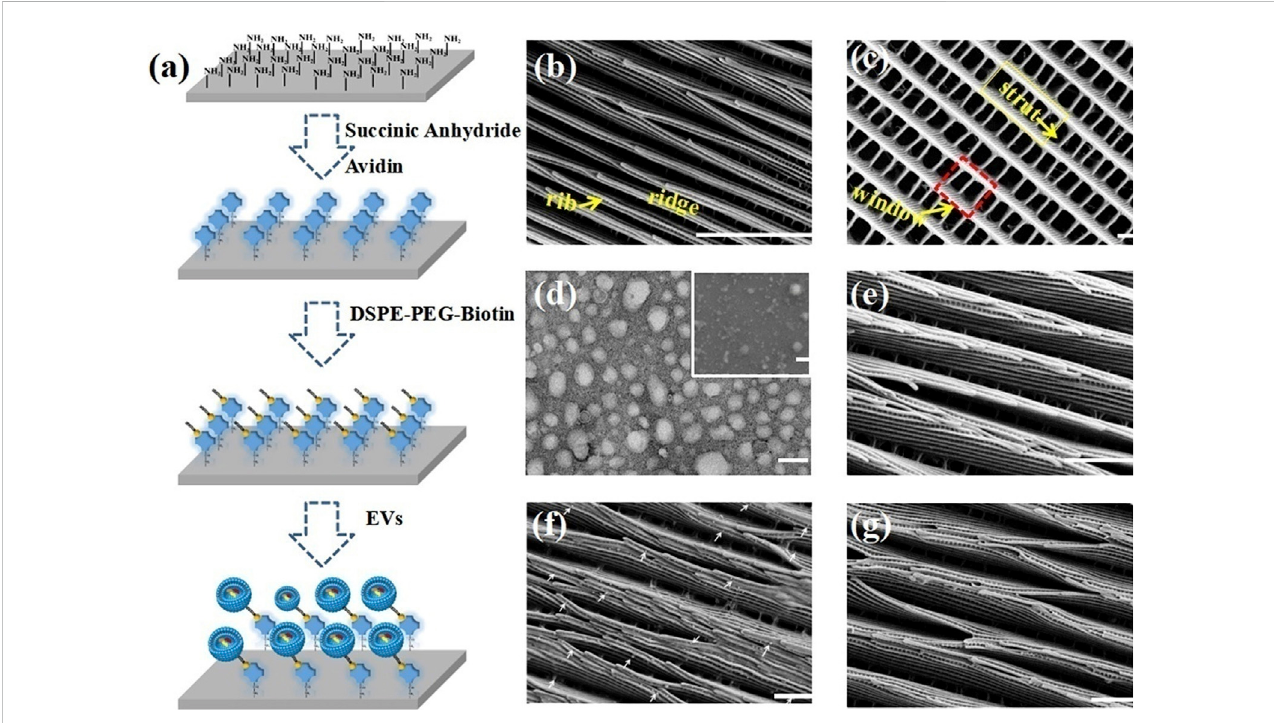
FIGURE 10 Modi fi cationofM.MenelauswingbylipidnanoprobesandSEMimagesofM.Menelauswingsatdifferentstagesoftheprocess. (A) Schematicdiagramof themodi fi cationprocessoflipidnanoprobesonthesurfaceofM.Menelauswing. (B,C) SEMimageofwingstructure. (D) TEMimageoftheEVs. (E) SEMimage of EVs captured by M. Menelaus wing without lipid nanoprobes modi fi cation. (F) SEM image of EVs captured by lipid nanoprobes modi fi ed M. Menelaus wing (asshownbythewhitearrow). (G) SEMimageofEVscapturedbyM.Menelauswingaftertreatmentwithtriethylamine.Reproducedwithpermissionfrom (Han et al.,